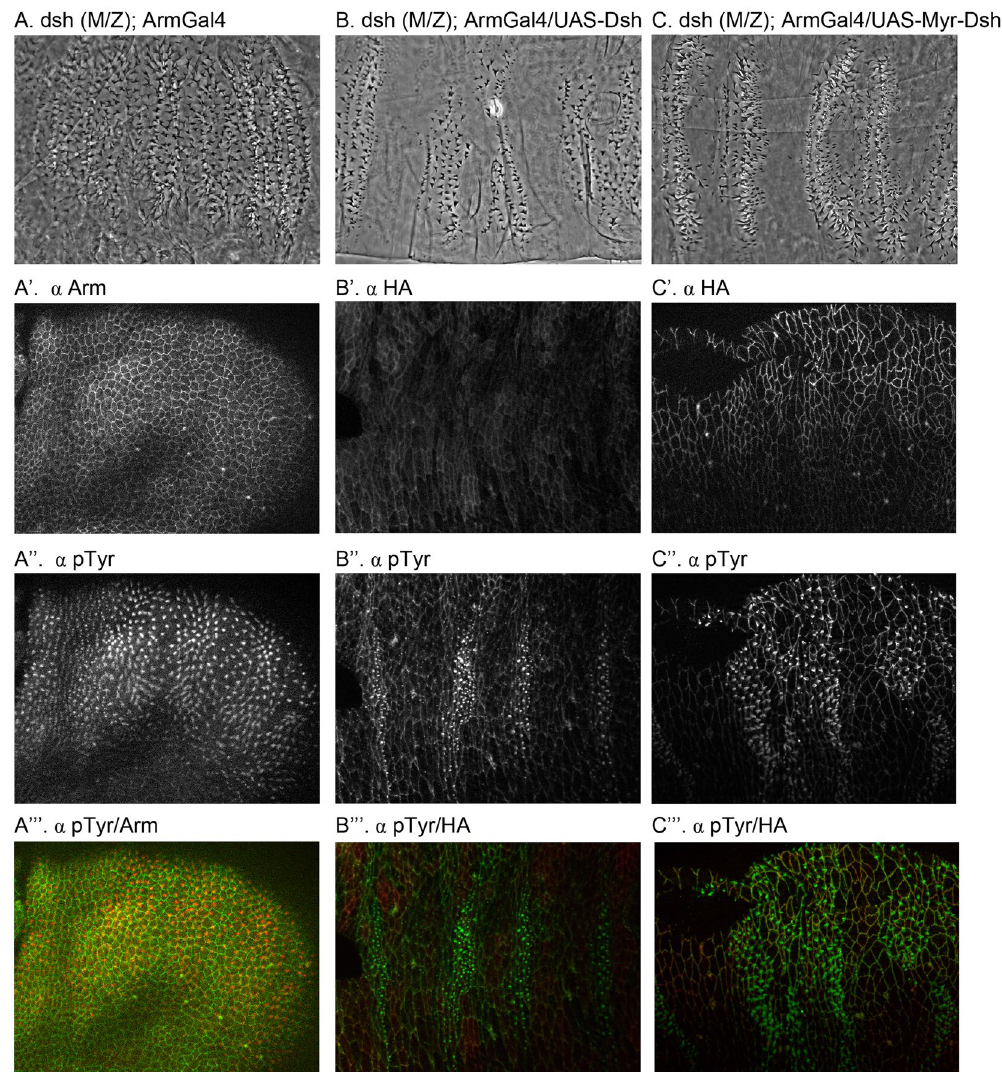
Figure 2. Cuticle preparations of ( A ) dsh (M/Z) mutant showing a lawn of denticles without activation of signaling. ( B ) dsh (M/Z) mutant embryo expressing Dsh resulting in expansion of naked cuticle. ( C ) dsh (M/Z) mutant embryo expressing Myr-Dsh showing signaling activation phenotype. (A’-A”) dsh (M/Z) mutant embryo stained for Arm and denticle precursors (pTyr). (B’-B”) dsh (M/Z) mutant embryo expressing Dsh stained for ectopic tag HA and denticle precursors (pTyr). Similar staining in dsh (M/Z) mutant embryo expressing Myr- Dsh (C’-C”).”’ panels show merged